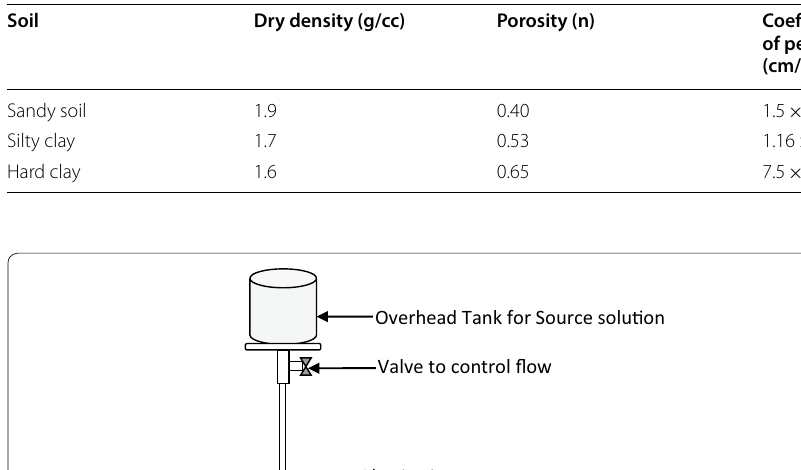
Table 3 Characteristics of contaminated soil